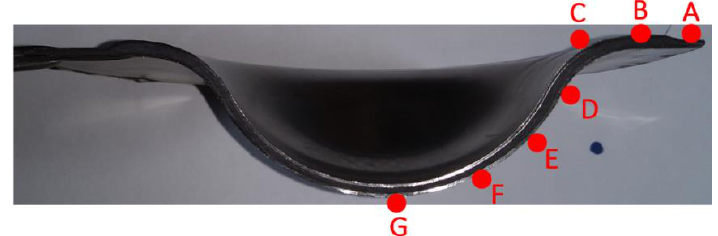
Figure 19. Point labels in the cross-section of steel-composite sandwich for thickness measurement. Table 5. Thickness on the cross-section of steel-composite sandwich (unit: mm).